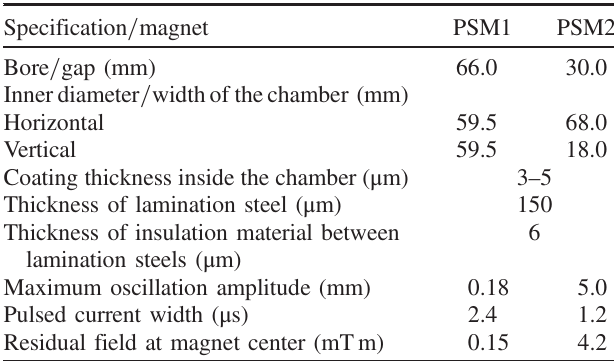
TABLE I. Horizontal oscillation amplitudes at injection for PSM1 and PSM2, along with their